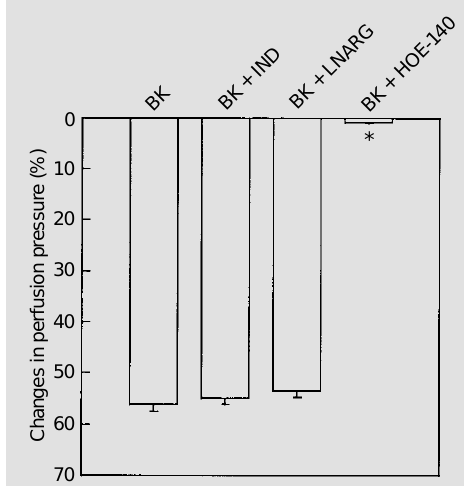
Figure 3 - Vasodilator effect of bradykinin (BK; 40 ng) in the ab- sence or in the presence of the cyclooxygenase inhibitor in- domethacin (BK + IND; 5.5 µM), or the NO synthase inhibitor N G - nitro-L-arginine (BK + LNARG; 200 µM), or the B 2 -kinin recep- tor antagonist HOE-140 (BK + HOE-140; 250 nM). Values (mean ± SEM) represent the percent decrease in mesenteric perfusion pressure (N = 4-6). *P<0.05 vs BK (Student t